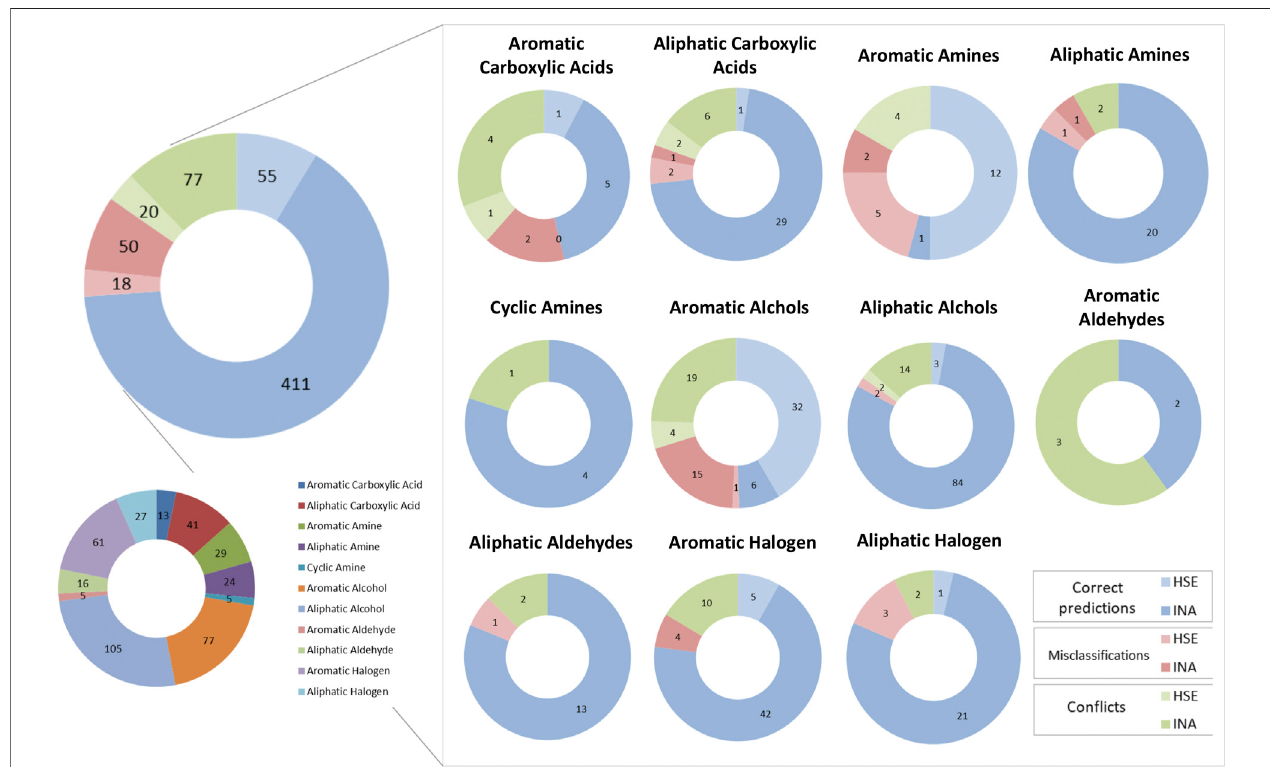
FIGURE 8 | Graphical representation of the number of concordant predictions, misclassi fi cations and con fl icts between the KNN and the BRF models across the various chemical classes of the ES. Blue slices of the pie charts indicate concordant correct predictions, Red slices indicate concordant misclassi fi cations, while green slices indicate con fl icts between the two models. Light-colored slices refer to experimentally HSE compounds, while dark-colored slices refer to experimentally INA compounds.